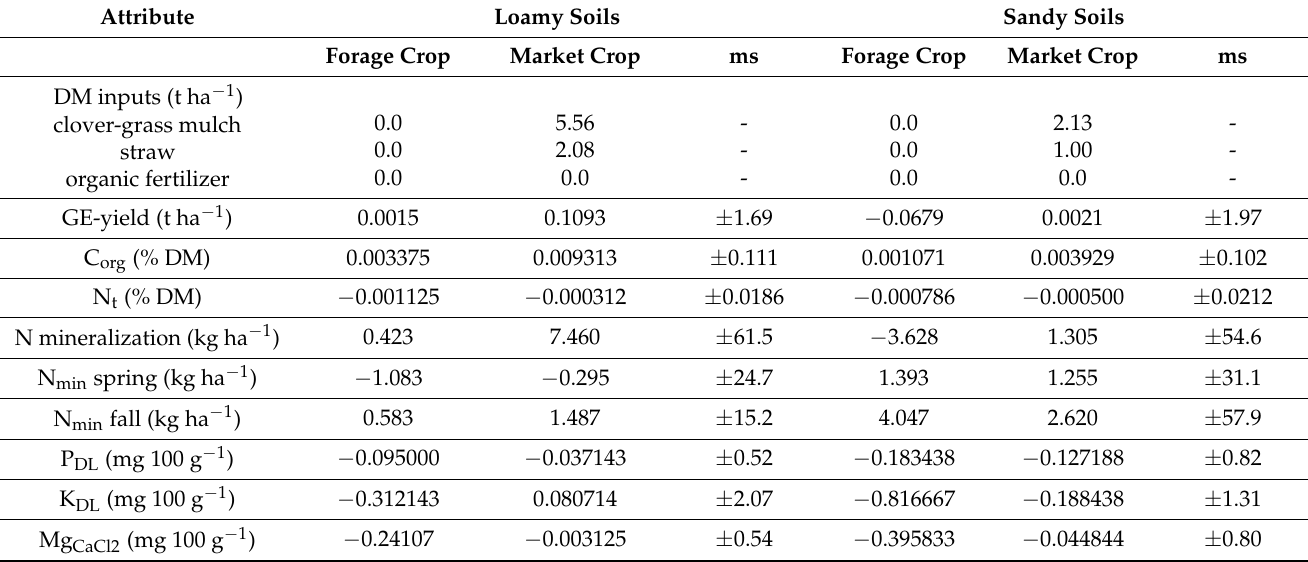
Table 4. Effects of the supply of organic materials in variants without fertilization on the annual change of certain characteristics from long-term experiments on loamy and sandy soils (accounting period: loam = 15 years, sand = 13 years, mean standard error regression,